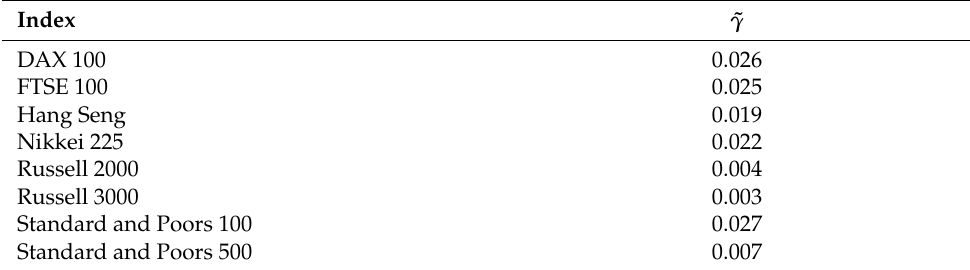
Figure 1. Penalty Parameter γ and Objective Function Values (lower is better). Table 2. Initial Guesses ˜ γ